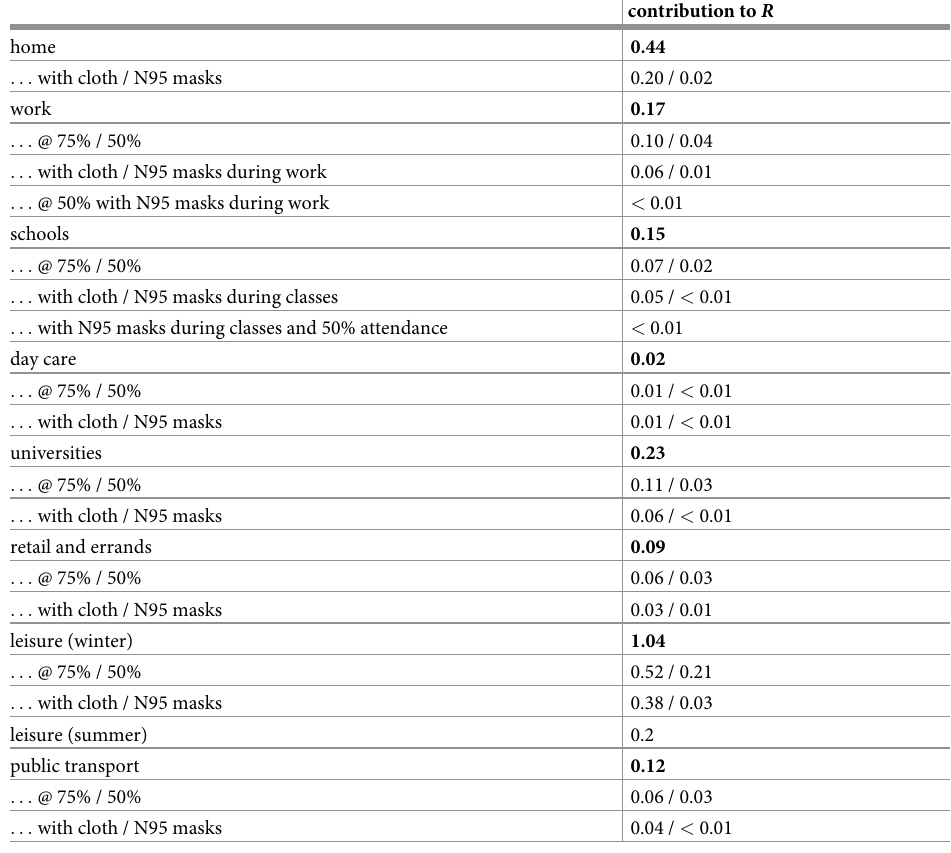
Table 2. Contributions to R by activity type and intervention according to our